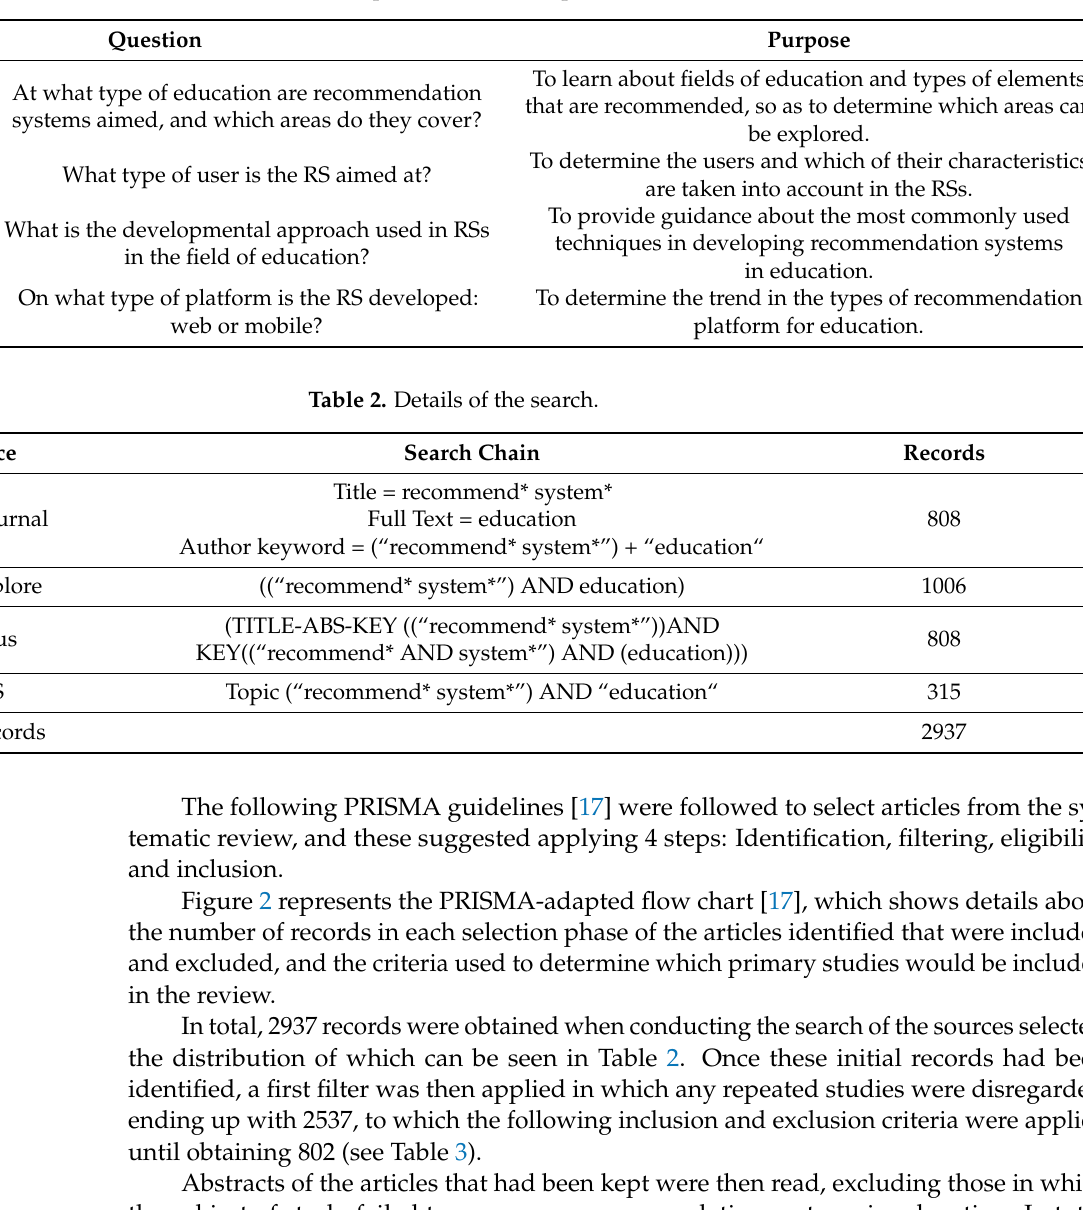
Table 1. Purpose of the search questions.